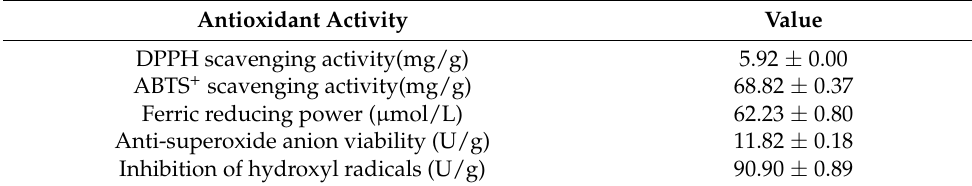
Table 5. The antioxidant activities of Gonostegia hirta